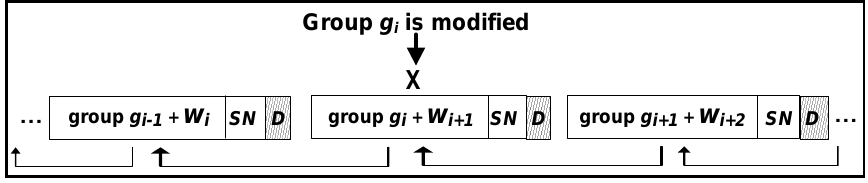
Figure 3. Data Modification Attack in Forward-chaining Watermarking